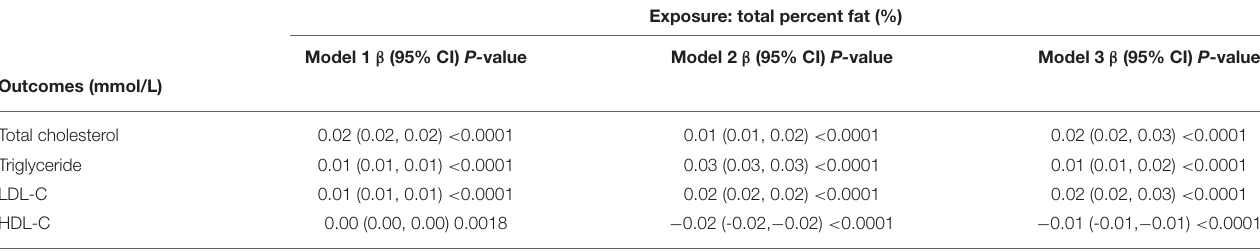
TABLE 2 | Associations between total percent fat (%) and lipid biomarkers (mmol/L).